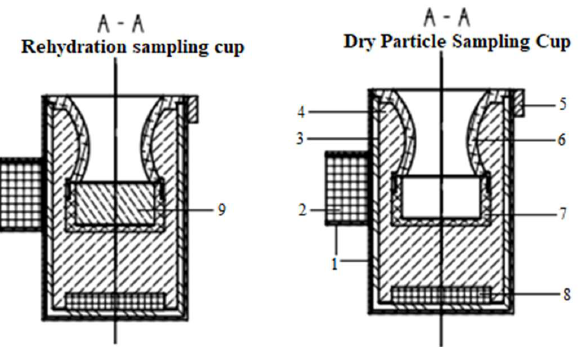
Figure 3. Diagram of a new double surface sampling cup structure. (1) Heat and magnetic insulation tape; (2) Connecting magnet; (3) Outer cup; (4) Frozen layer; (5) Wireless temperature and